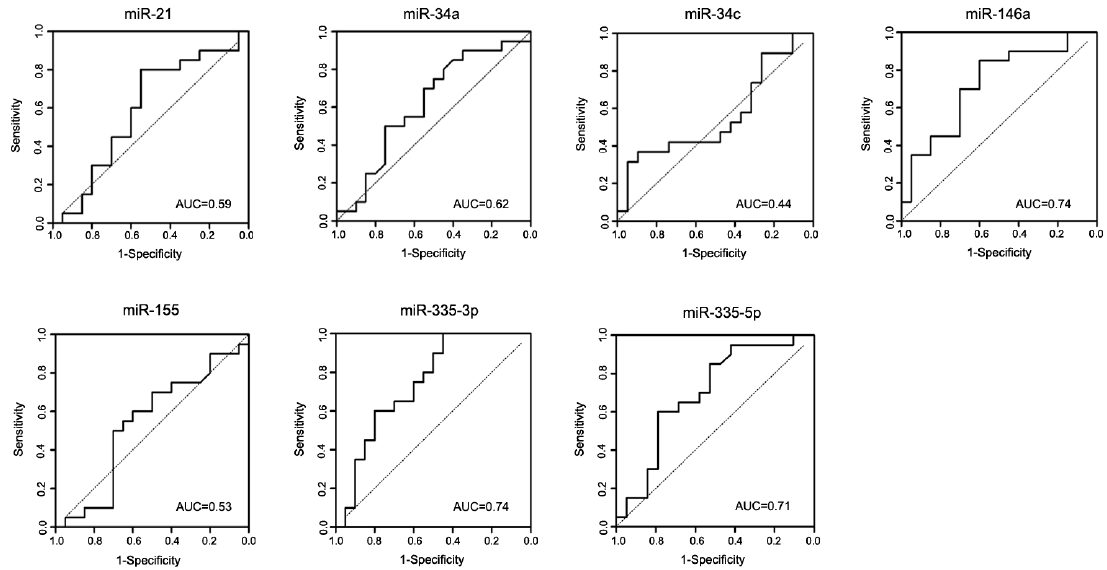
Figure 2. Receiver operating characteristic (ROC) curves of miRNAs in the discovery cohort, discriminating between iPD patients and controls. The true positive rate (sensitivity %) is plotted as a function of the false positive rate (100%—specificity) for the seven miRNAs individually. Area under the curve (AUC) values are indicated in each plot.